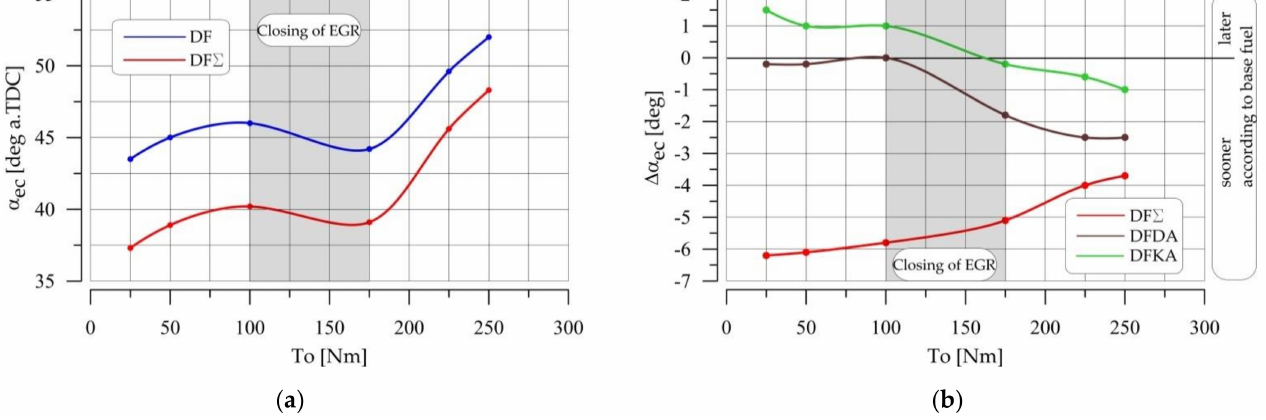
Figure 27. ( a ) Occurrence of the end of combustion vs. engine torque; ( b ) Difference in the occurrence of the end of combustion vs. engine torque in relation to the base